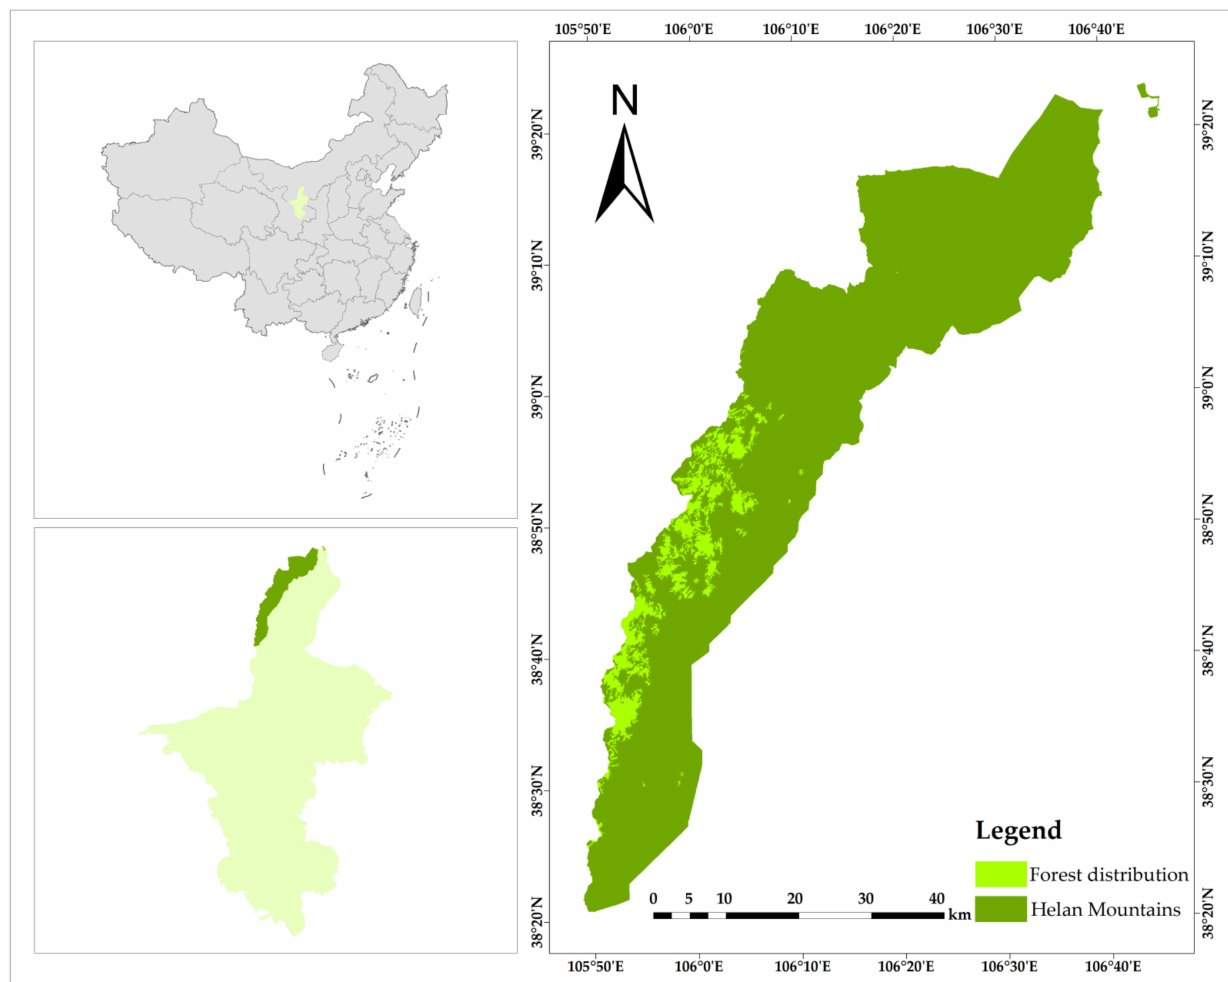
Figure 1. The geographical location of the Helan